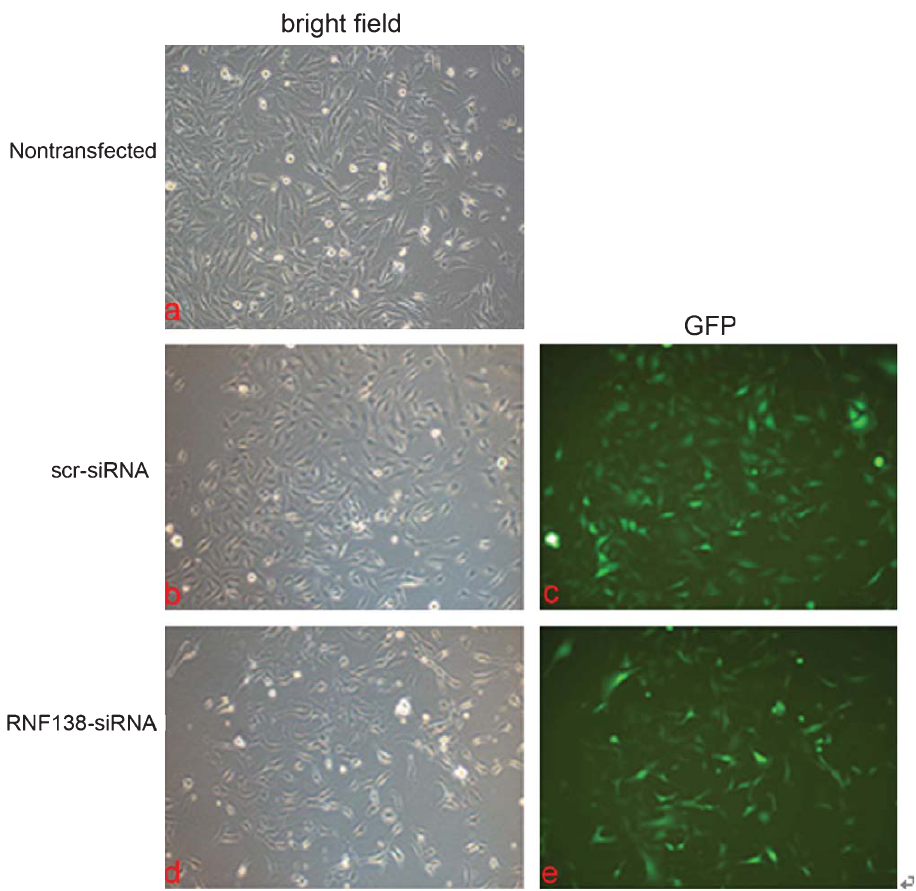
Fig. 3. Cells transfected with RNF138-RNAi-Lentivirus (KD) and negative-control-Lentivirus (NC) and nontransfected were observed under light microscopy (left) and fluorescence microscopy (right) after transfected with the specific lentivirus for 72h. More than 80% of U251 cells expressed GFP (right). No significant difference between the negative control group and the nontransfected group, indicating the transfection process has no effect on cells’ growth. a: 100 × B; b: NC 100 × B; c: NC 100 × G; d: KD 100 × B; e: KD 100 ×